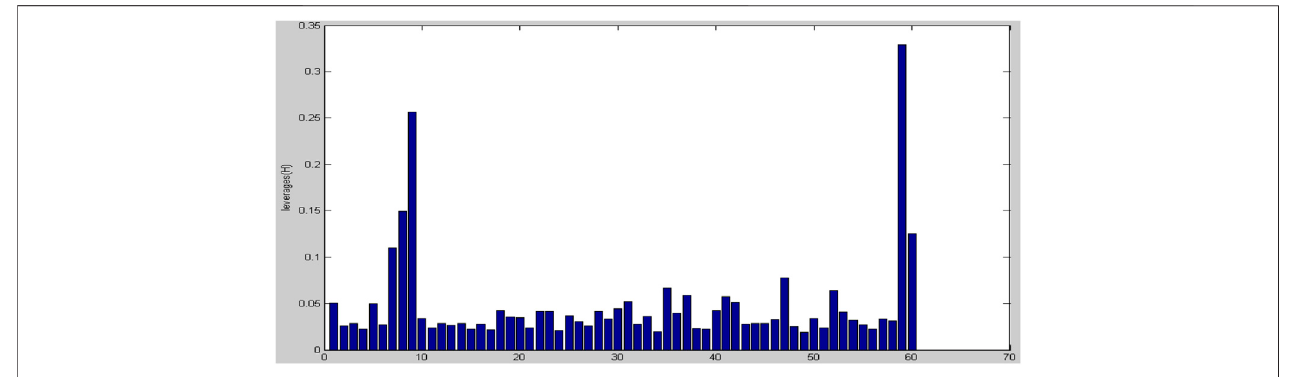
FIGURE 3 | The Leverage graph based on the number of samples.